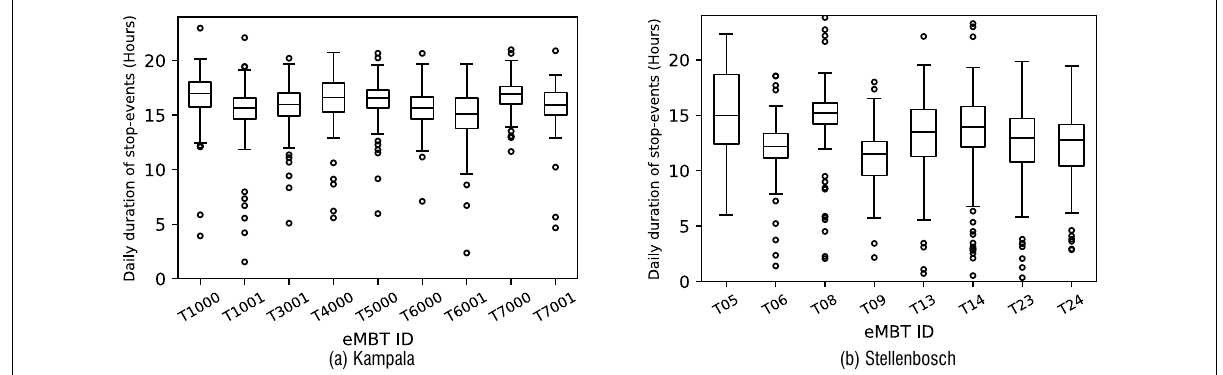
Figure 5: Daily durations of minibus taxi stop events with a minimum duration threshold of 20